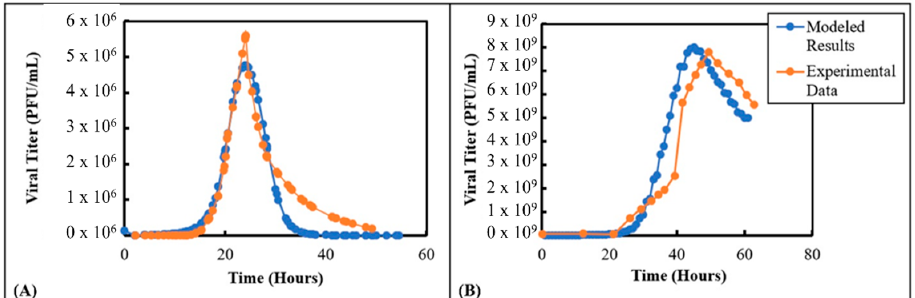
Figure 2. Parameter estimation results: The figure above shows the results of two parameter estimation attempts to capture data from the literature regarding viral vaccine production. ( A ) shows the results from parameter estimation for a measles vaccine. ( B ) shows the results of parameter estimation for a rabies vaccine. Both figures show viral titer results as given by experimental data and model prediction from parameters estimated by gPROMS [20].